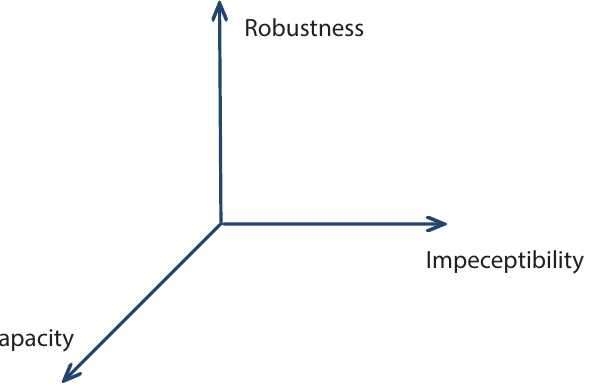
Figure 7. Constraints of digital